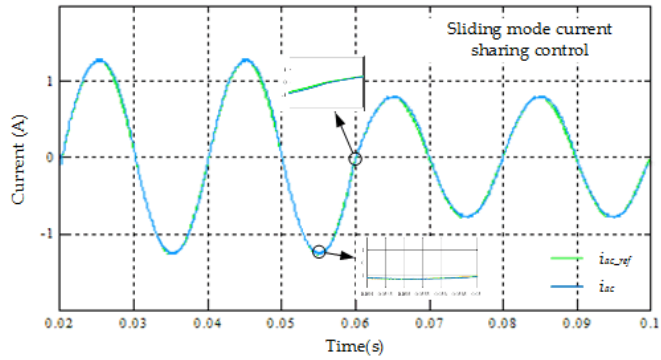
Figure 8. Simulation results of case 1: output grid current response of the interleaved flyback micro-inverter controlled by a SMC controller. Table 3. Different system parameters.